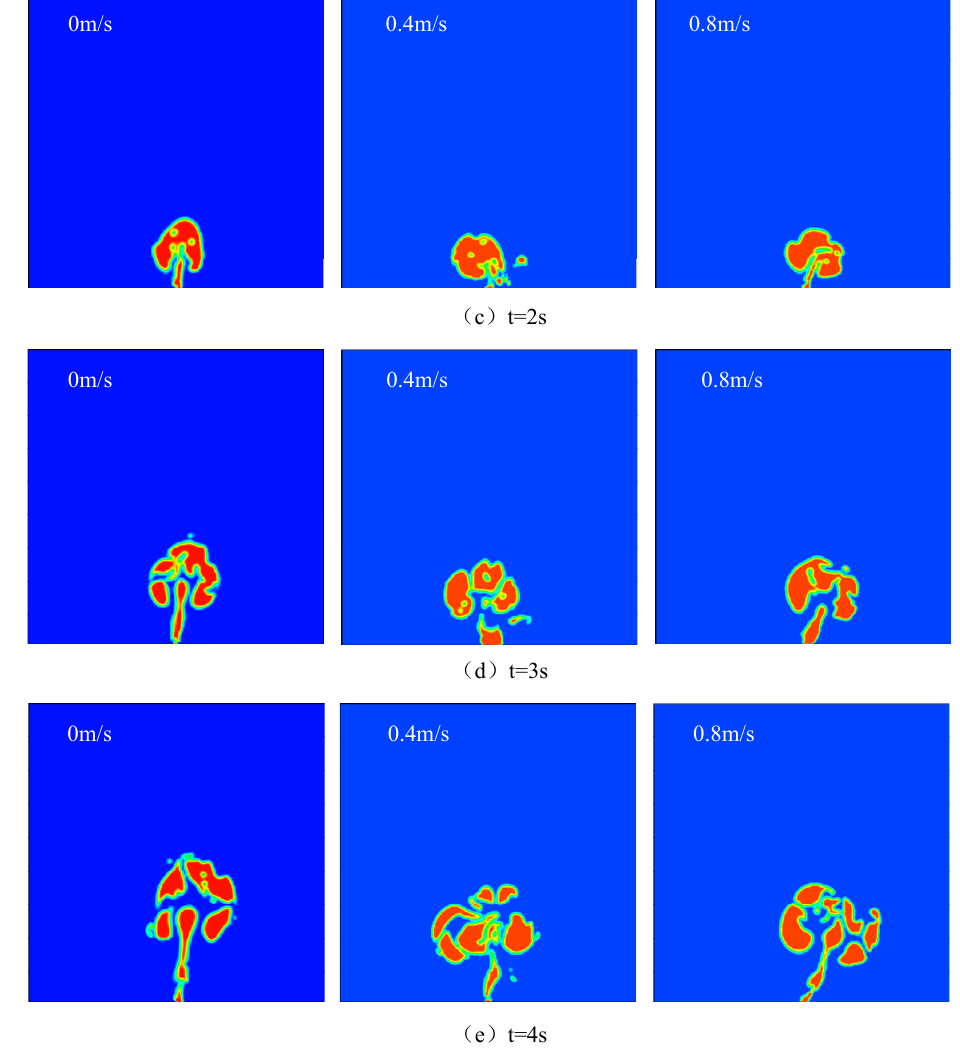
Figure 8. Cloud chart of natural gas leakage and diffusion of submarine pipeline at each time when the current velocity is 0 m/s, 0.4 m/s or 0.8 m/s, respectively.